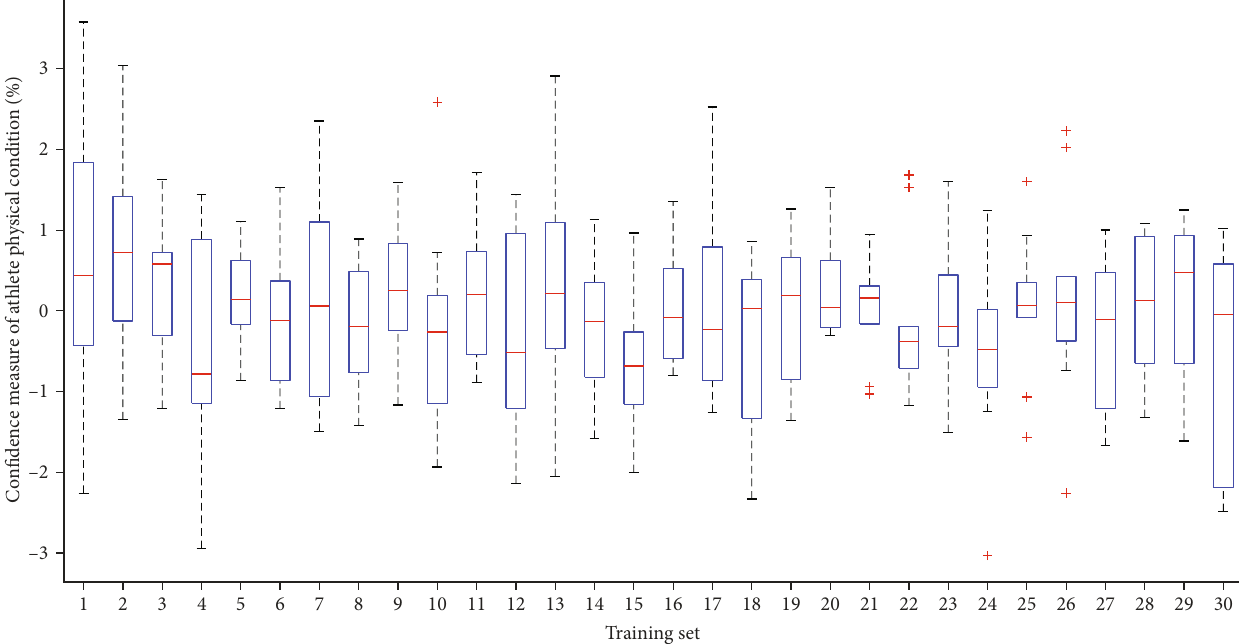
Figure 6: Con fi dence measurement curve of athlete ’ s physical